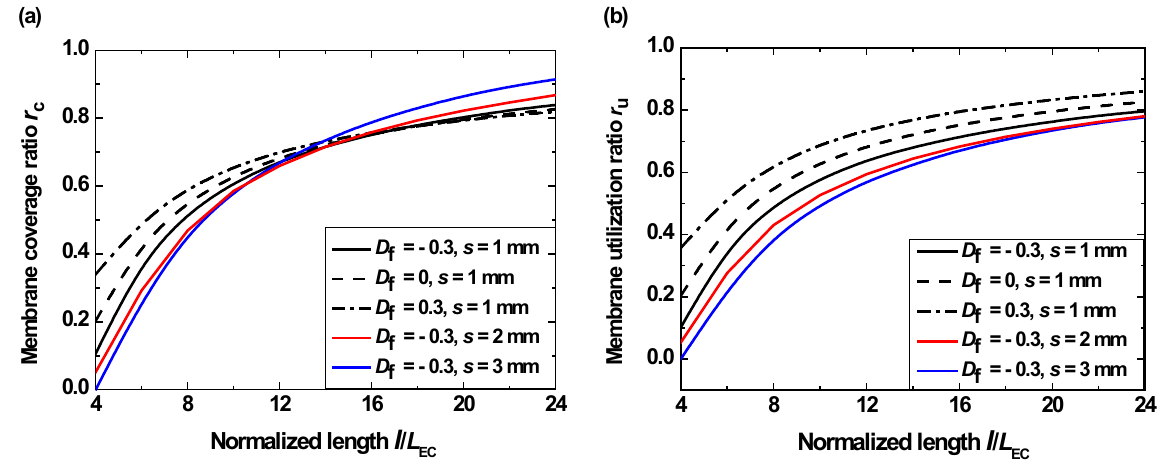
Figure 10. Schematic illustrations and optical images of the changes in the membrane bending behavior for different deployment factors when θ